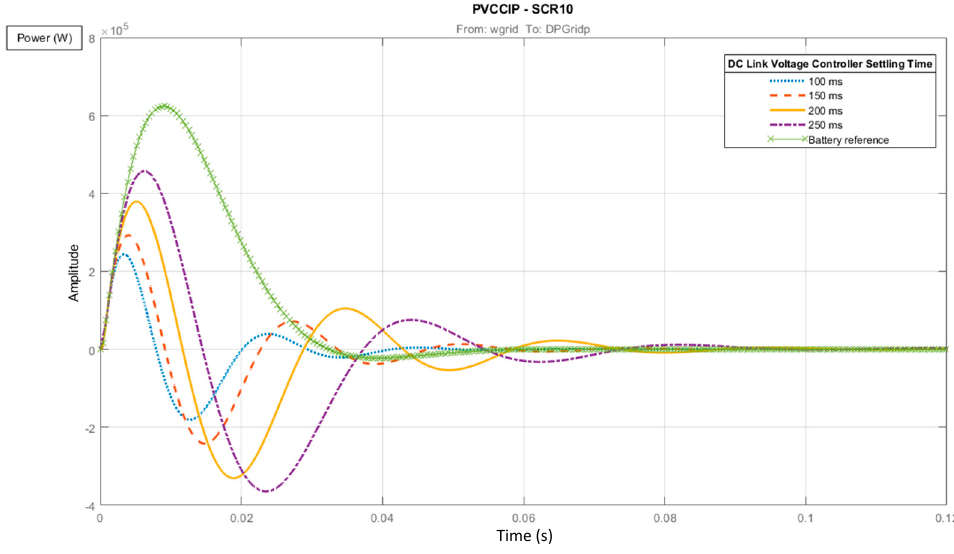
Figure 22. Step showing the effect of the DC link controller bandwidth on the PVCCI frequency response.